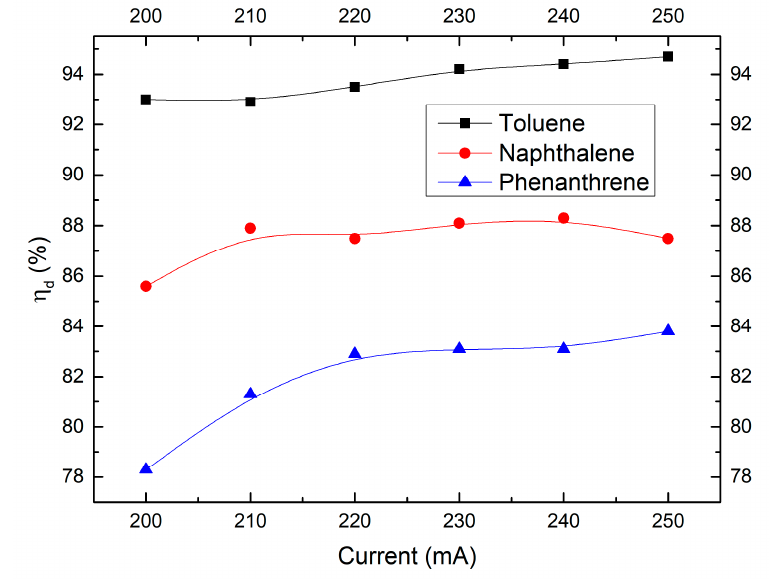
Figure 13. Effect of discharge current on destruction efficiency.